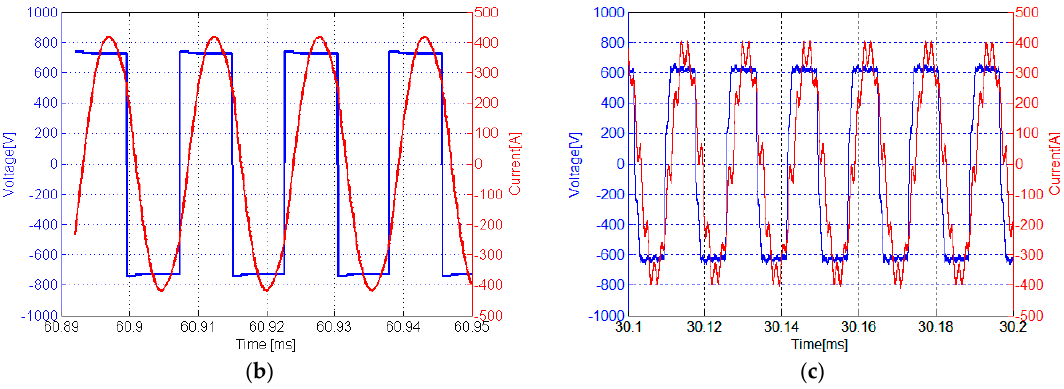
Figure 13. Simulated and measured inverter output voltage and current waveforms: ( a ) Circuit simulation model; ( b ) Simulated results at 180 kW transfer; and ( c ) Measured results at 172 kW transfer.